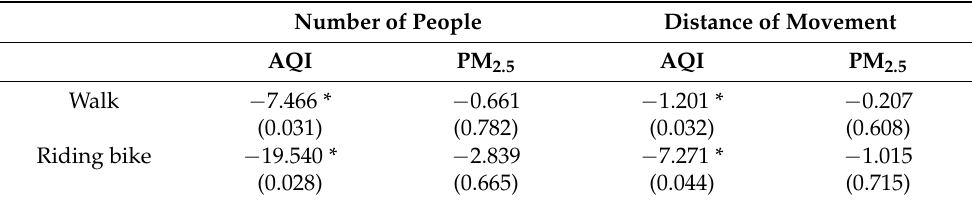
Table 6. The effects of air quality on walking and cycling